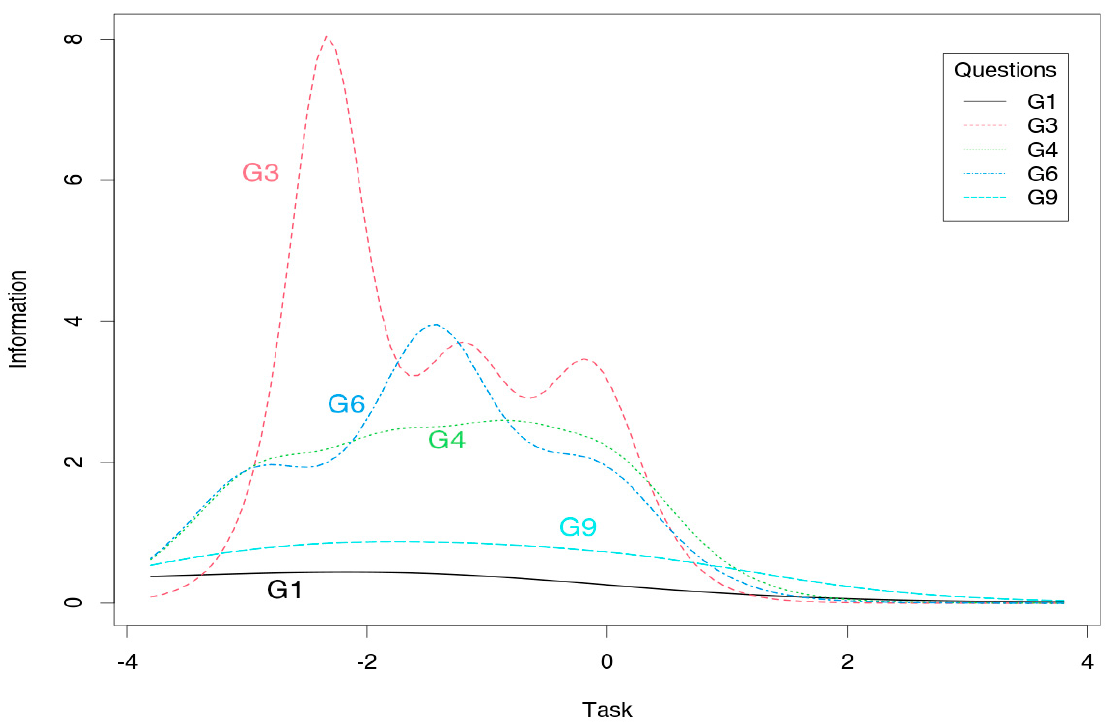
Figure 5. Information curves for the task subscale items of the GOEM scale.